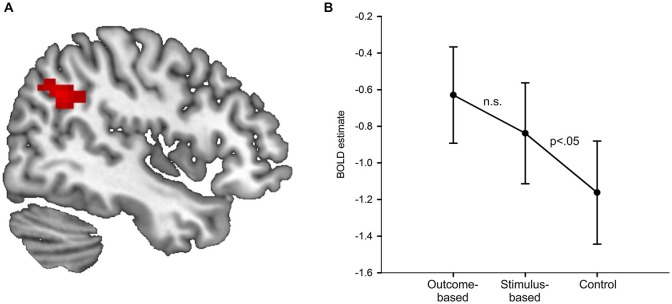
Results of the univariate analysis. (A) Result of the comparison of brain activation between the outcome-based and the control condition (cluster-corrected p < 0.05 corresponding to at least 66 adjacent voxels with uncorrected p < 0.001). Activation in the right angular gyrus was significantly higher during outcome-based blocks. (B) BOLD estimates for each of the conditions within the angular gyrus ROIs derived from a leave-one-subject-out analysis. Error bars reflect standard errors.